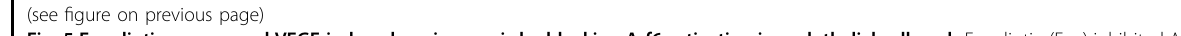
Fig. 5 Evogliptin suppressed VEGF-induced angiogenesis by blocking Arf6 activation in endothelial cells. a , b Evogliptin (Evo) inhibited Arf6 activation in VEGF-treated HUVECs and mice with OIR. a Arf6-GTP levels were measured in HUVECs treated with or without Evo and VEGF for 15 min (three independent experiments). b Mice with OIR received a single intravitreal injection of Evo or DMSO (Cont) on P12, and retinal tissues were harvested from normal mice and mice with OIR on P13 ( n = 3 mice). In a and b , cell and tissue lysates were prepared for Arf6-GTP pulldown analysis. The signal intensity of the protein bands was determined by densitometry, and the band intensities of phosphorylated proteins were normalized to those of the total proteins. c , d Treatment with an Arf-GAP inhibitor abolished the inhibitory effect of Evo on the VEGF-induced activation of c Arf6 and d the angiogenic signaling pathway in HUVECs. Cells pretreated with QS11 were incubated with or without Evo and VEGF for Arf6-GTP pulldown and western blotting (three independent experiments). e – g Treatment with an Arf-GAP inhibitor abolished the inhibitory effect of Evo on the VEGF- induced angiogenic activity of endothelial cells. e Tube formation, f scratch wound migration, and g spheroid sprouting assays were performed with HUVECs treated with or without QS11, Evo, and VEGF. Tubular length, the relative area covered by migrating cells from the wound edges (black dashed lines), and the length of sprouts were measured as previously described ( n = 4 for tube formation assay, n = 8 for scratch wound migration assay, and n > 19 for spheroid sprouting assay). Scale bars = 200 μ m. All data are presented as the mean ± SEM (one-way ANOVA with